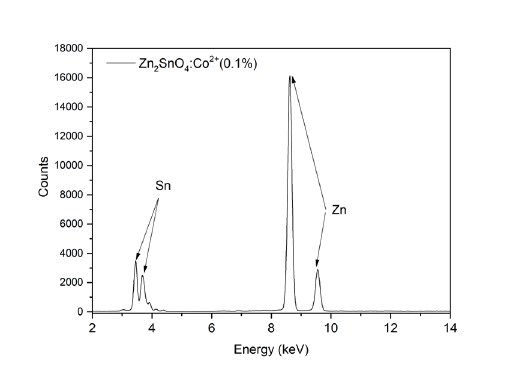
SnO :Co 2+ (0.1%), with magnifications of (a) x7, (b) x32, (c) x362, 2 4